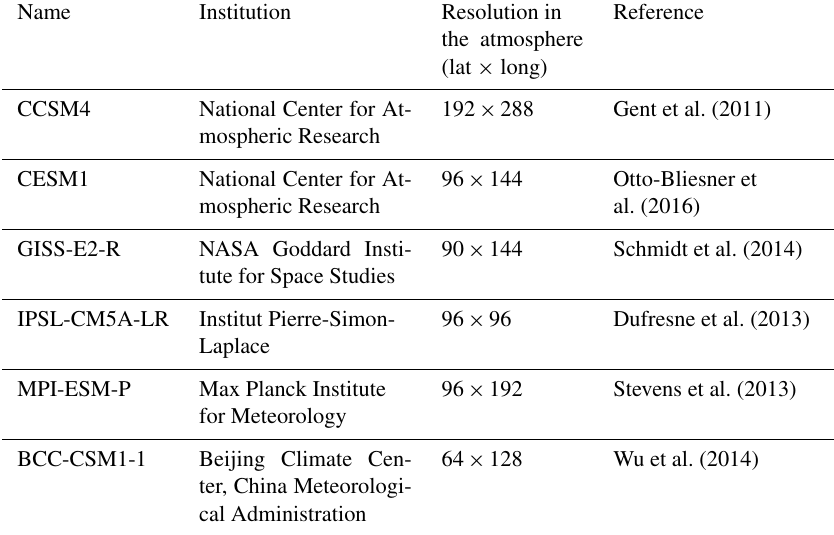
Table 1. Climate model simulations used to drive